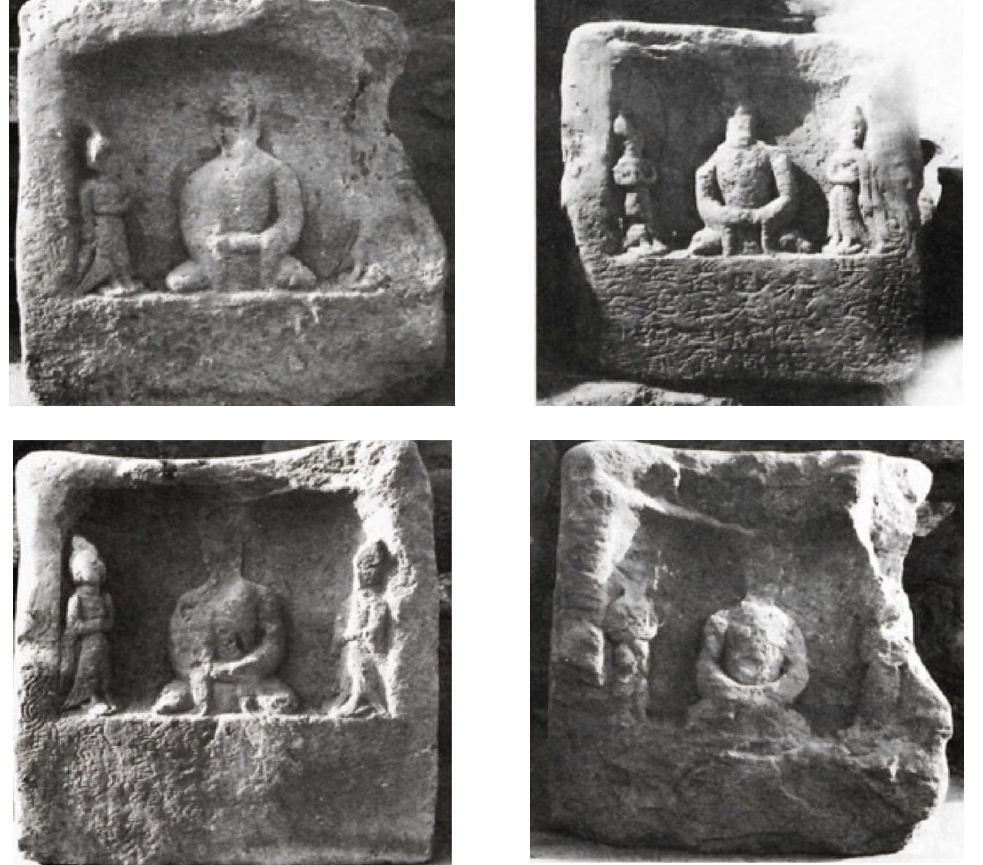
Figure 5. Stone Block from Chanfo Monastery, Kongtong District, Pingliang City, Gansu Province. 503, Northern Wei. H. 44 cm, W. 33 cm. Pingliang Museum. Reprinted with permission from ref. [Gansu fojiao shike zaoxiang]. 2000, Zhang, p. 99.